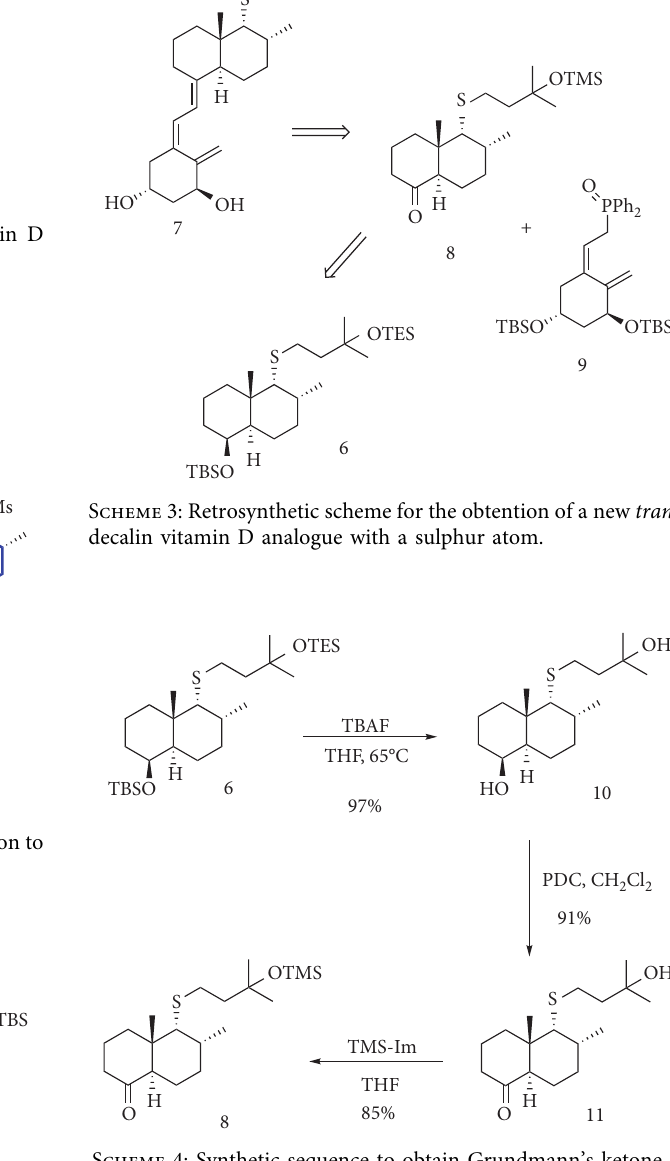
Scheme 4: Synthetic sequence to obtain Grundmann’s ketone